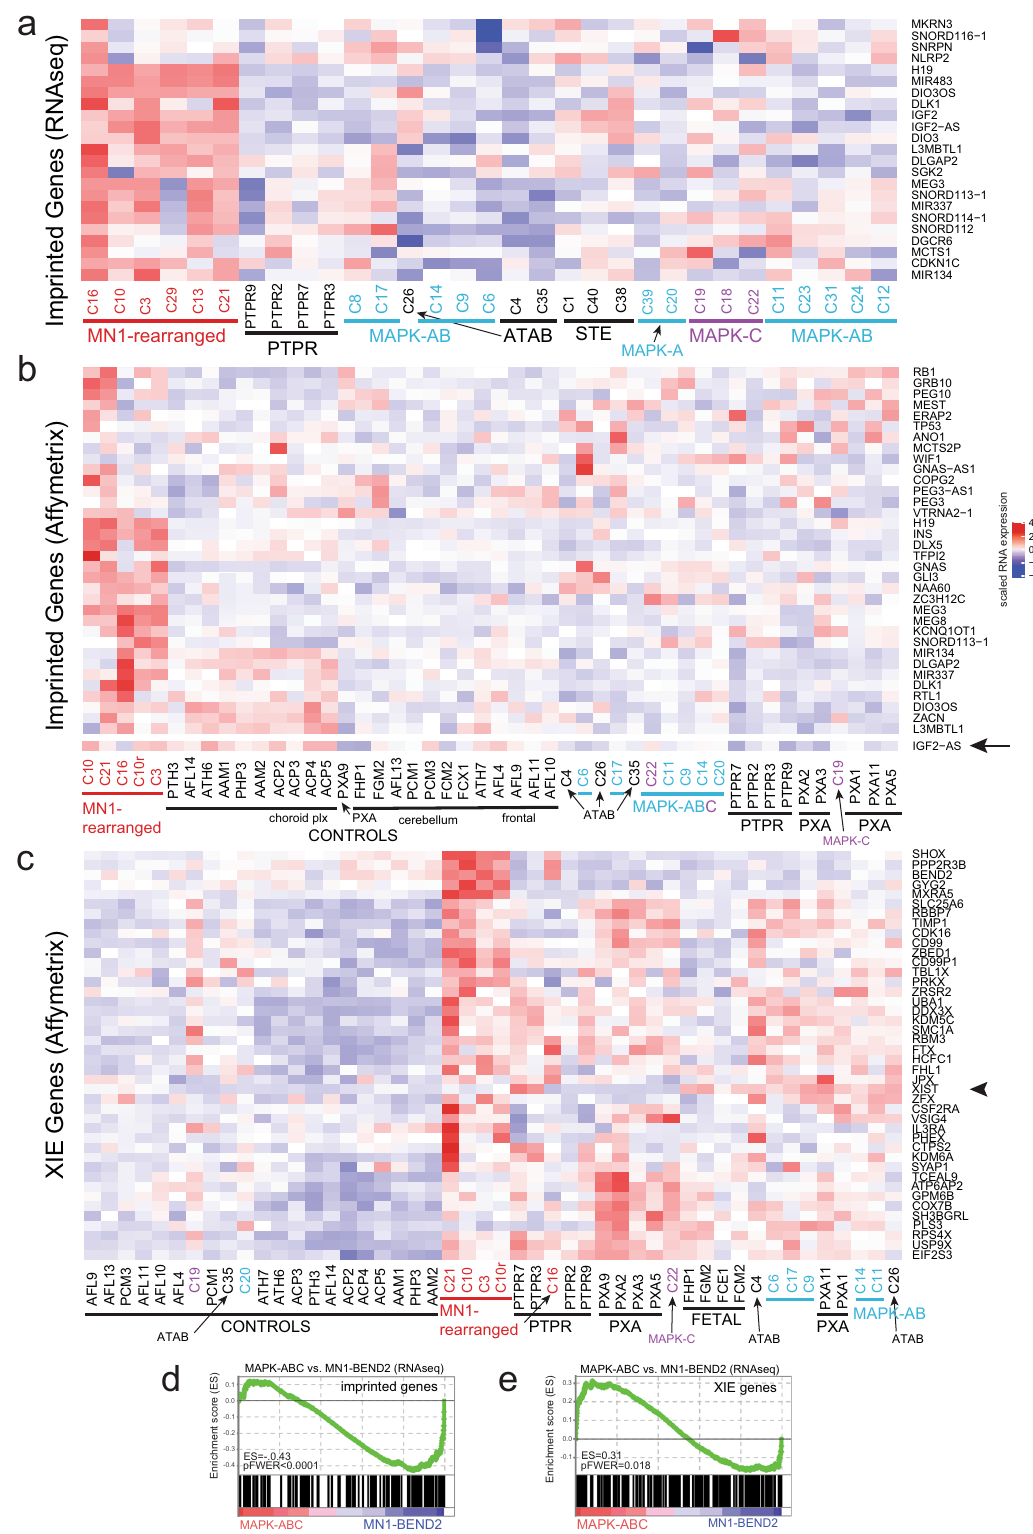
Considering all genes in all AB-like tumors, fusions were 4.9- fold more frequent in female versus male patient tumors (Table 2). Fusions involving chromosome X were 5.3-times more common in tumors from females ( P = 0.017) and occurred almost entirely in MN1-BEND2 and BRAF V600E -mutant tumors.